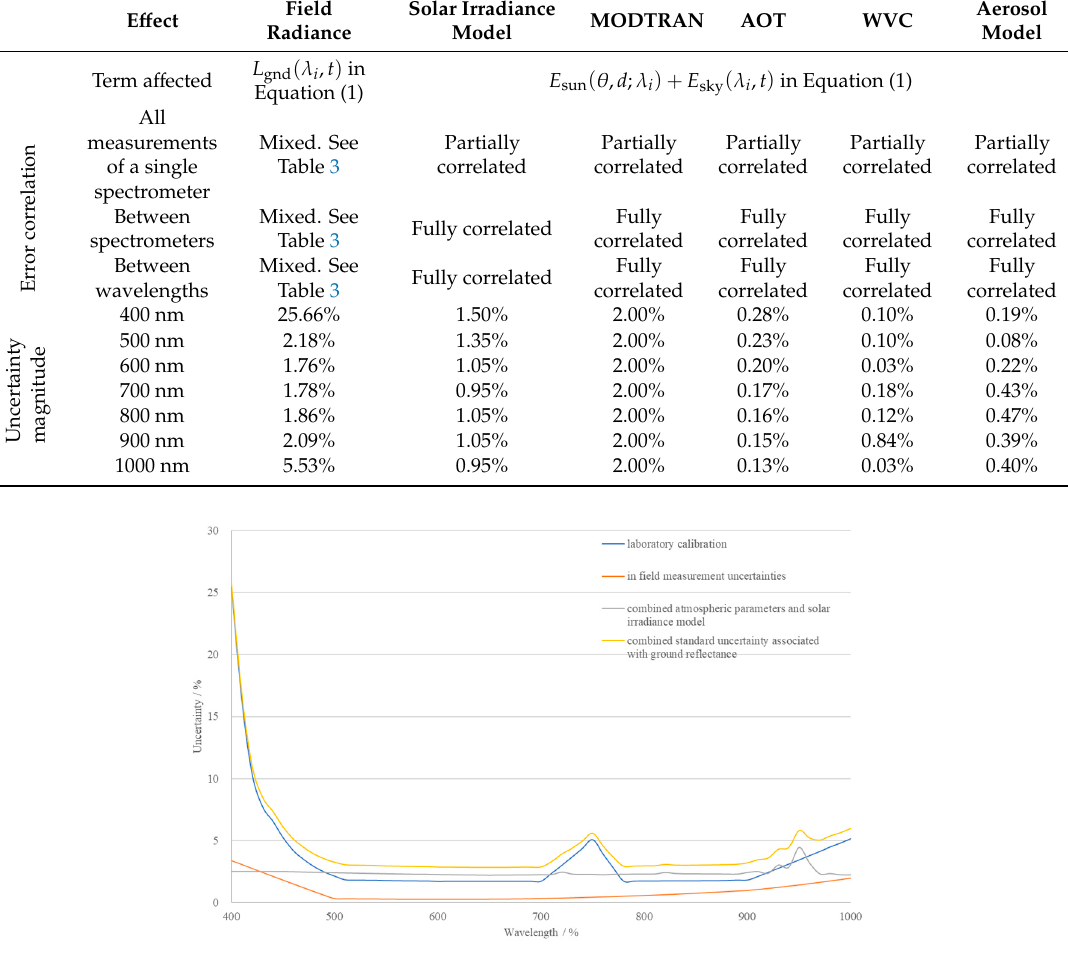
Figure 13. The combined uncertainty associated with ground reflectance.